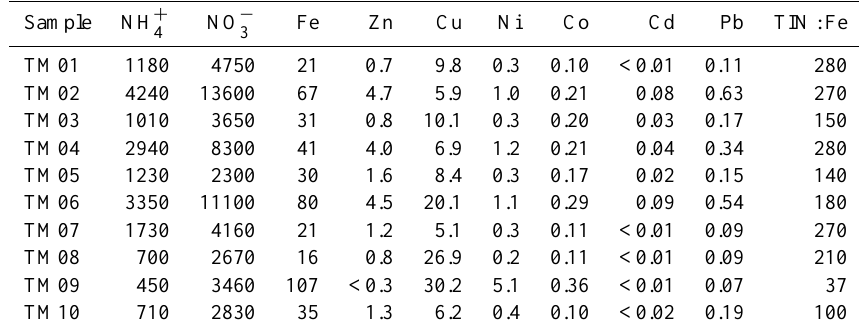
Table 5. Dry deposition fluxes (nmolm − 2 d − 1 ) of aerosol soluble components and the ratio of total inorganic nitrogen to soluble Fe deposi- tion (TIN:Fe) during the M91 cruise. Deposition velocities used to calculate fluxes are described in the text.